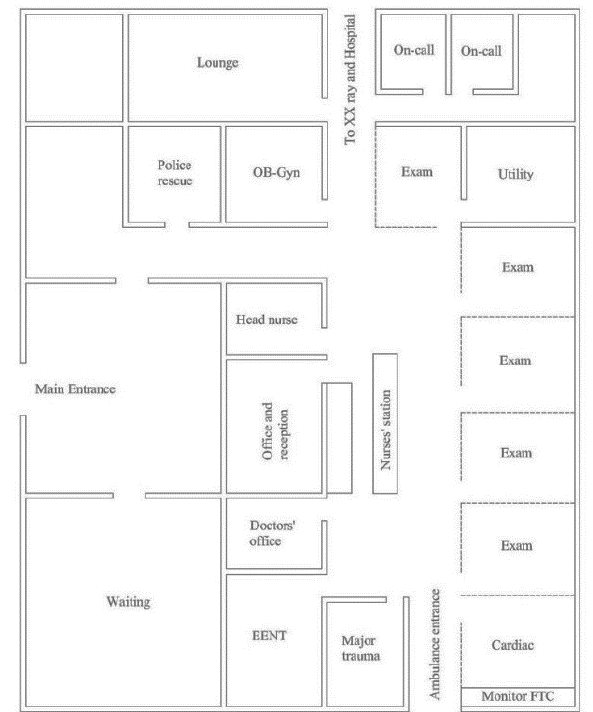
Fig. 3. Arena Type Plan for Emergency